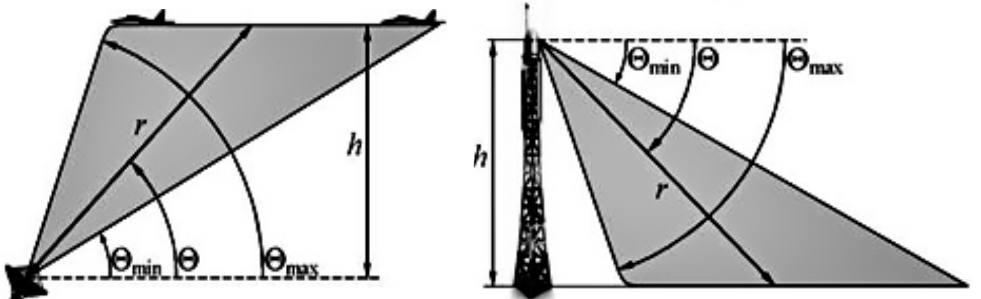
Figure 12. Examples of using the cosecance radiation pattern [68].